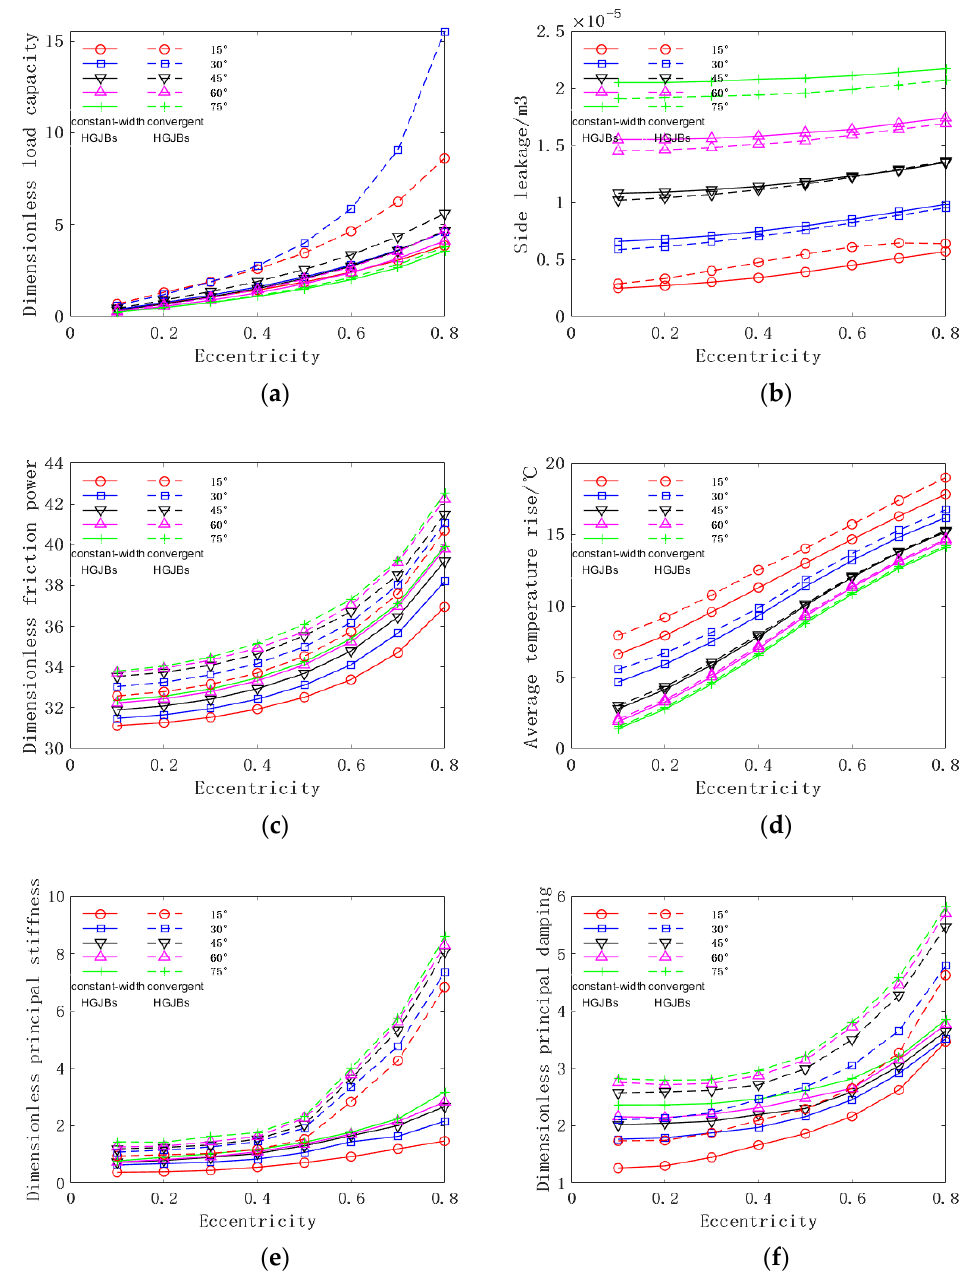
Figure 16. The influence of helix angle on the performance of HGJBs: ( a ) Dimensionless load capacity ( b ) Side leakage ( c ) Dimensionless friction power ( d ) Average temperature rise ( e ) Dimensionless principal stiffness ( f ) Dimensionless principal damping.